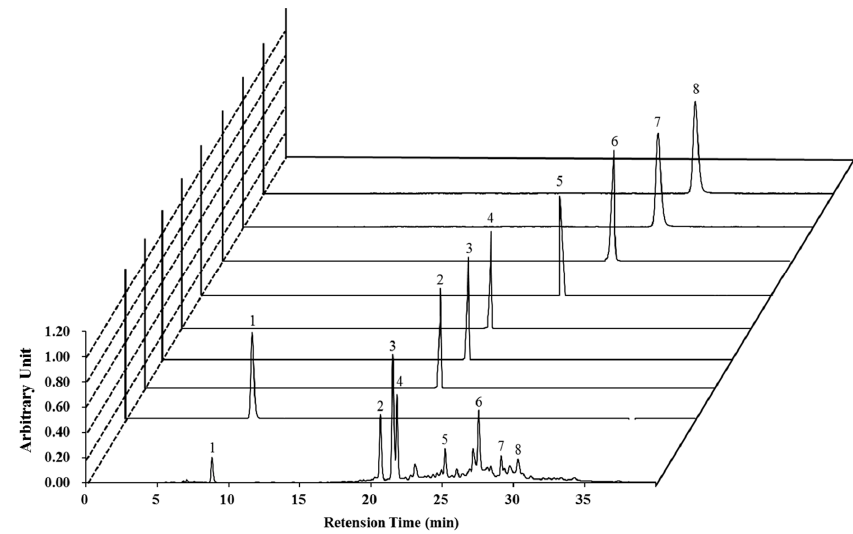
Figure 1. Representative high performance liquid chromatography profile of the methanolic extract of Nymphaea nouchali flower with standards monitored at 280 nm. Gallic acid ( Peak 1 ), catechin ( Peak 2 ), epicatechin gallate ( Peak 3 ), epigallocatechin ( Peak 4 ), epicatechin ( Peak 5 ), caffeic acid ( Peak 6 ), quercetin ( Peak 7 ), and apigenin ( Peak 8 ) are presented.